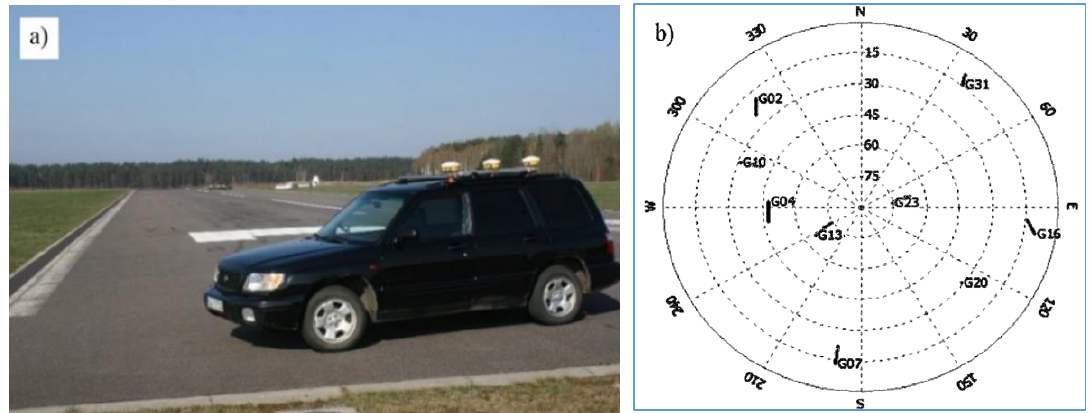
Figure 2. Test area: ( a ) airfield runway with a mobile GNSS unit; ( b ) satellite configuration during the experiment.